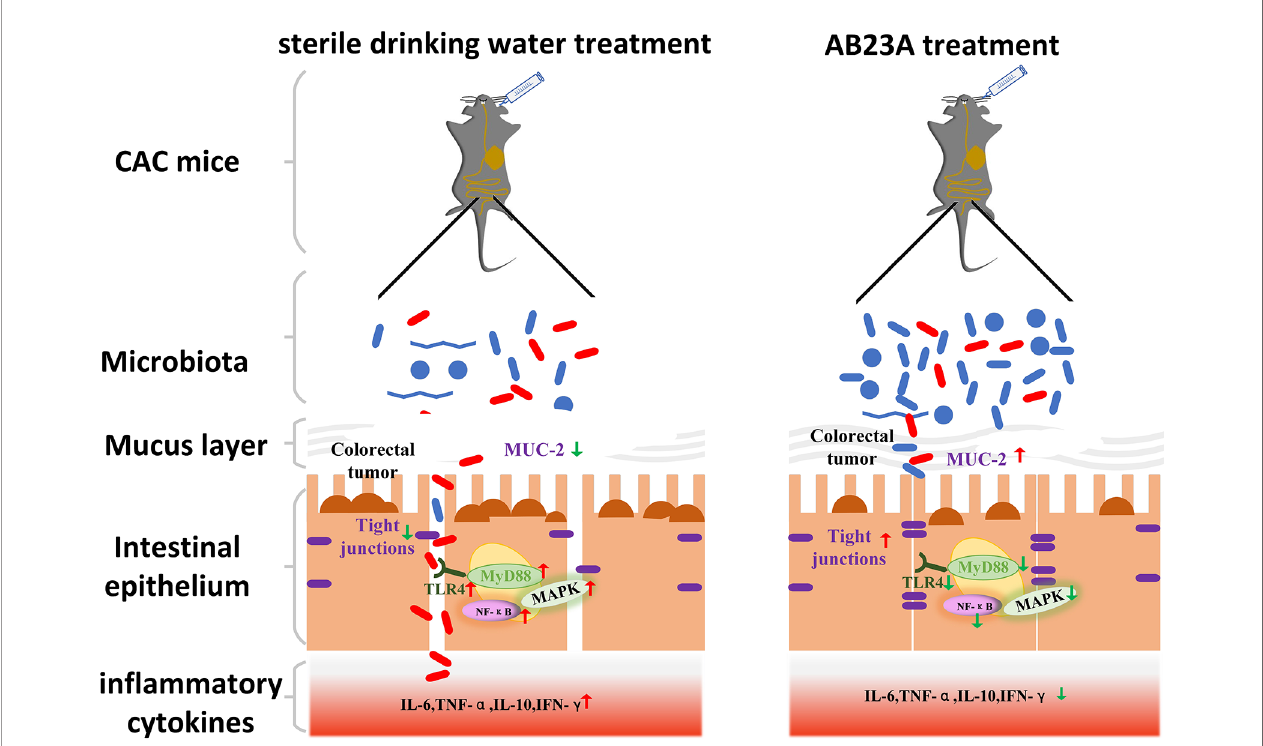
FIGURE 8 | AB23A Ameliorates CAC mice model, at least partially, via modulating the composition of gut microbiota, improving the intestinal barrier and inhibiting the activation of TLR4, NF- k B, and